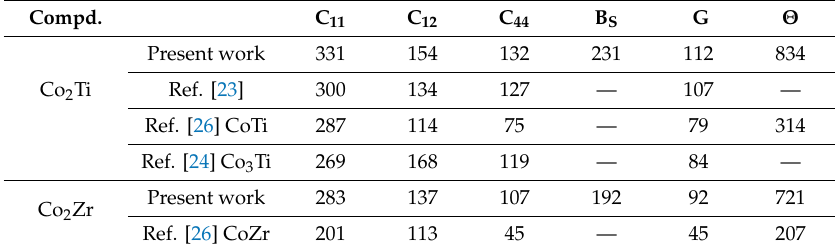
Table 2. The C ij (GPa), B S (GPa), G (GPa) and Θ at 0 GPa and 0 K.